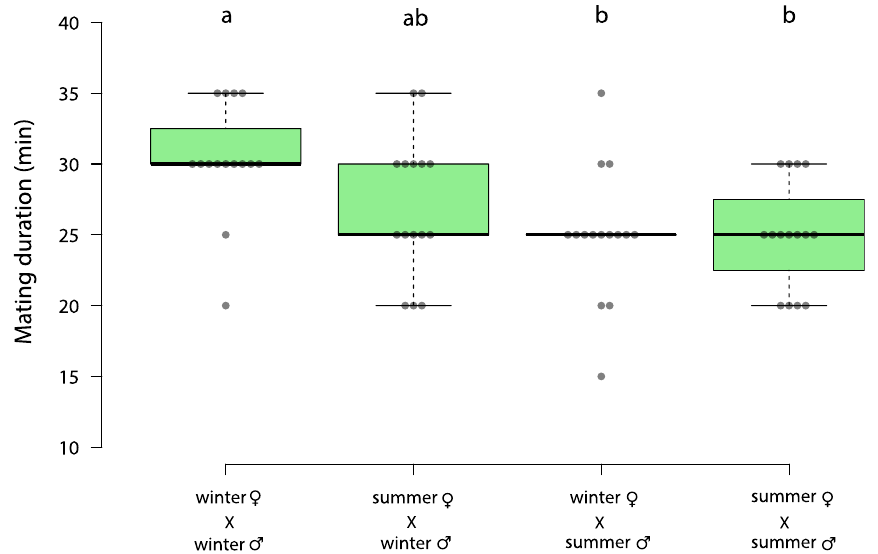
Figure 4. Box plot representing the mating duration of D. suzukii . Center lines show the medians; box limits indicate the 25th and 75th percentiles, whiskers extend 1.5 times the interquartile range from the 25th and 75th percentiles, n = 15 mating pairs per treatment. One-way ANOVA (effect of mating group F = 5.00 p < 0.004) with Tukey’s multiple comparisons post hoc test was performed. Different letters show significant differences ( p < 0.05).